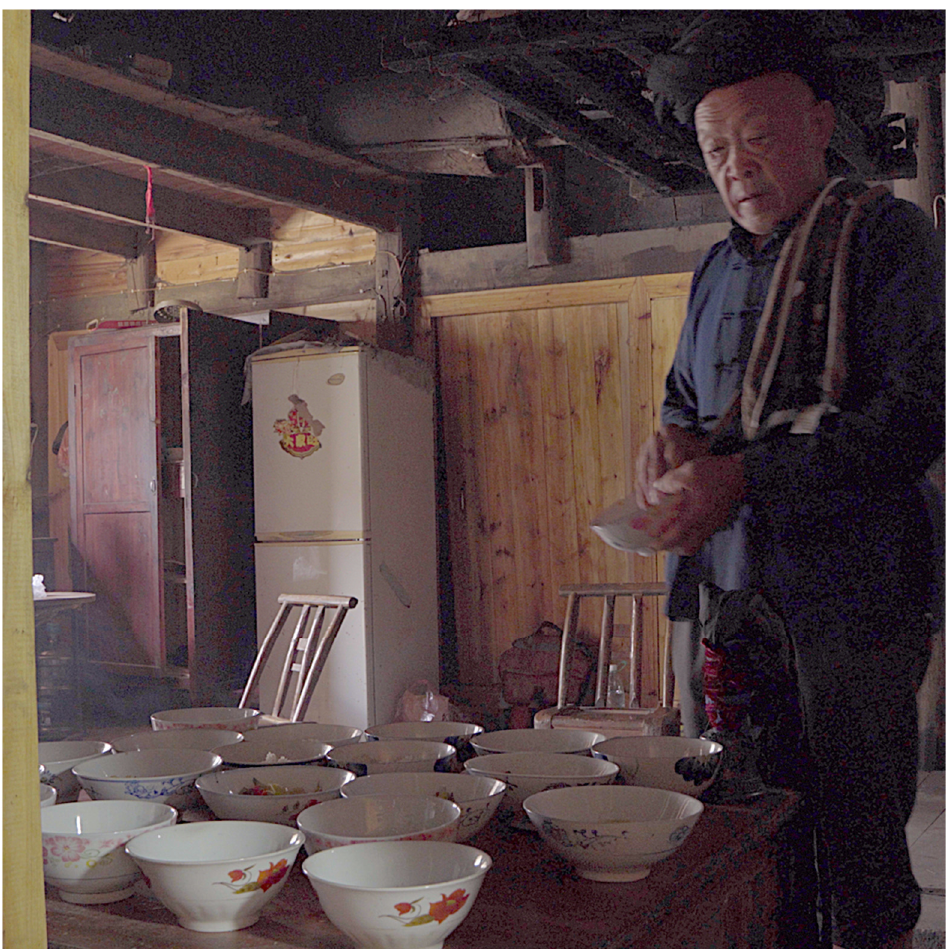
Figure 12. Badai Tian making food offerings for the gods at the inside altar. (Photo: Thomas Riccio). Tian chanted invitations in the Miao language, which was punctuated with the ring- ing of a bell. Only badaixiong use the bell. The chants ask the gods to “come peacefully god, the other filled with millet for the male god. A third bowl was filled with peach water. and don’t worry about anything. We will serve you as you like” (Tian 2018b). with the harvest of the season, buckwheat, ramie, soy, maize, wheat, sorghum, and oats, each a crop the gods enjoy. Each crop filled three bowls and, when multiplied by seven, equaled twenty-one, which was numerologically auspicious for receiving the gods from heaven (Tian